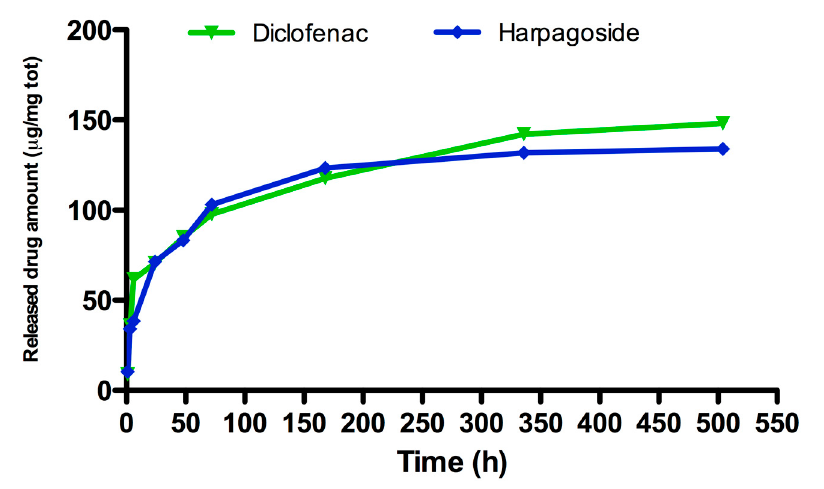
Figure 2. Release study of diclofenac 1 µ M and harpagoside (HR) 75 µ M from CaP-based materials by using the spectrophotometric method starting from 1 h to 504 h (21 days) of incubation at 37 °C. Data are reported as drug amount released from total milligrams (70 mg) of paste.